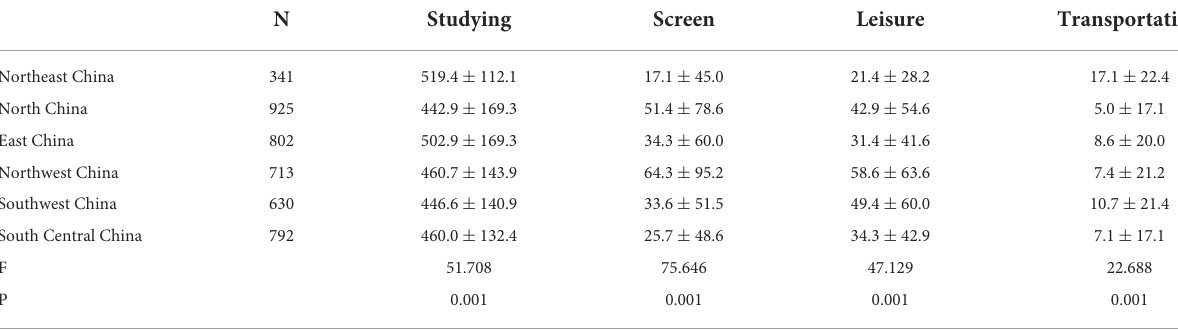
TABLE 6 Comparison of sedentary types of children and adolescents in different regions.